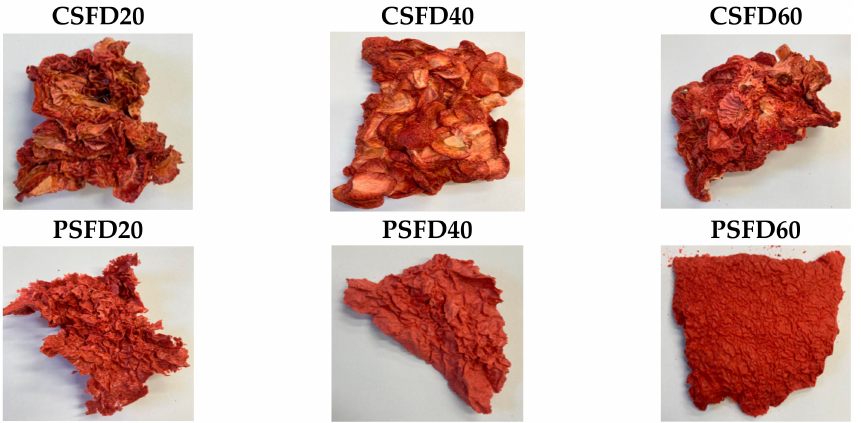
Figure 3. Freeze-dried strawberry slices (CS) dehydrated at 20 ◦ C (CSFD20), 40 ◦ C (CSFD40), and 60 ◦ C (CSFD60), and freeze-dried strawberry pulp (PS) dehydrated at 20 ◦ C (PSFD20), 40 ◦ C (PSFD40), and 60 ◦ C (PSFD60). Table 6. Color coordinates of raw and freeze-dried strawberries and water